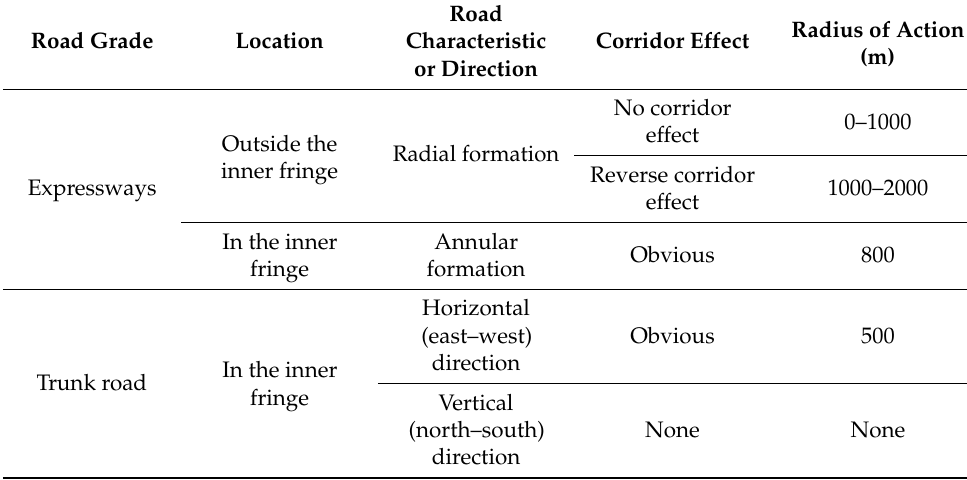
Table 9. Different corridor effect with various grades, locations, and